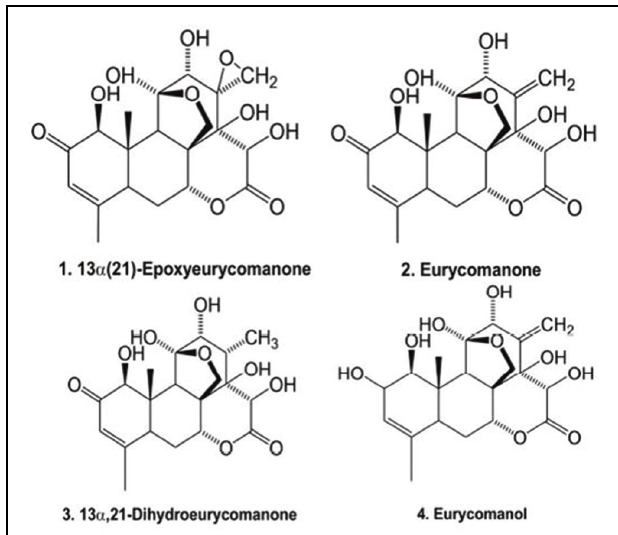
FIGURE 1 | The active ingredients of Eurycoma longifolia F2